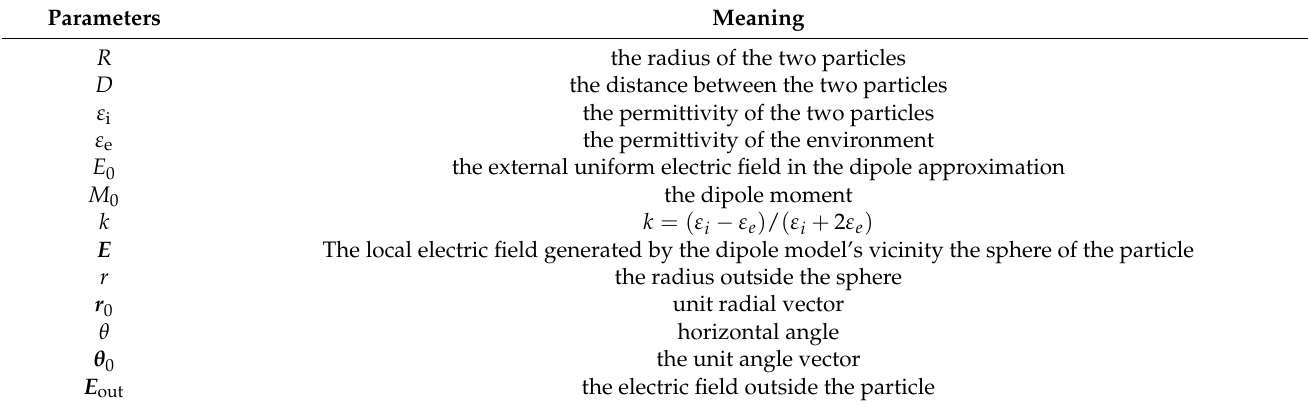
Table 1. The parameters used in this